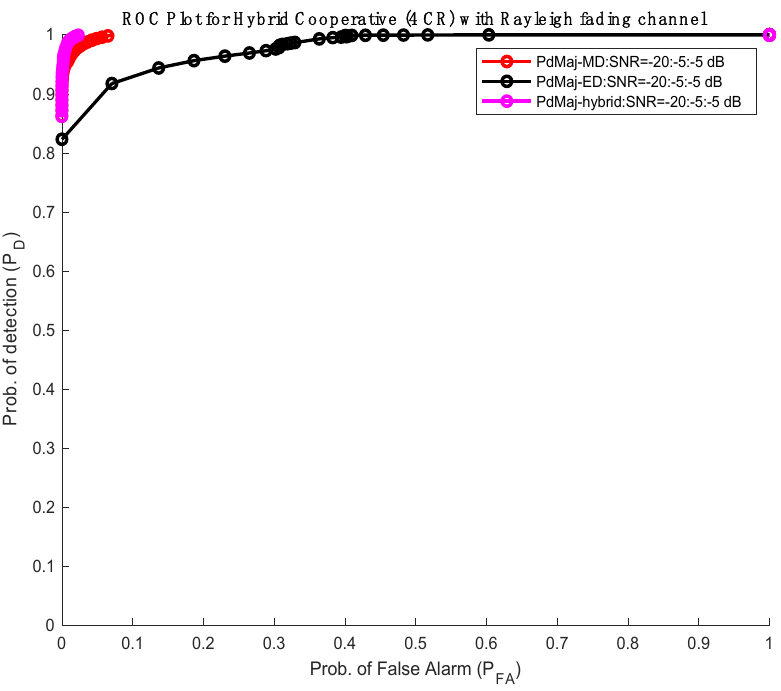
Figure 10. Hybrid detector under CSS (4): AND for case 2 .